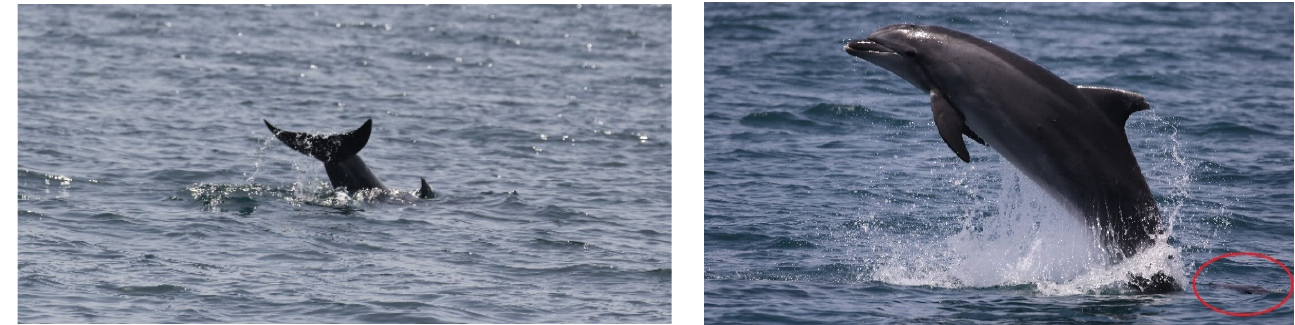
Figure 4. The individual “B” ( bottom dolphin) swimming close to the putative mother ( upper dolphin).